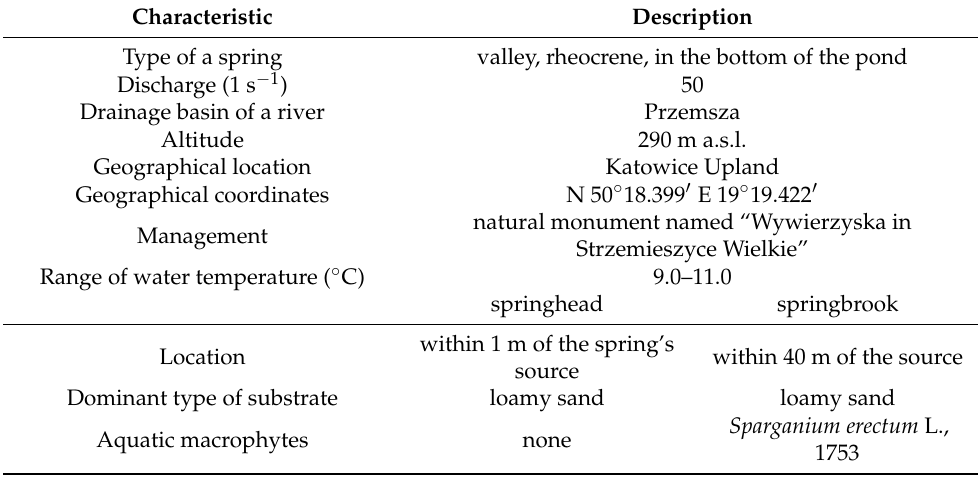
Table 1. Characteristics of the spring and the sampling